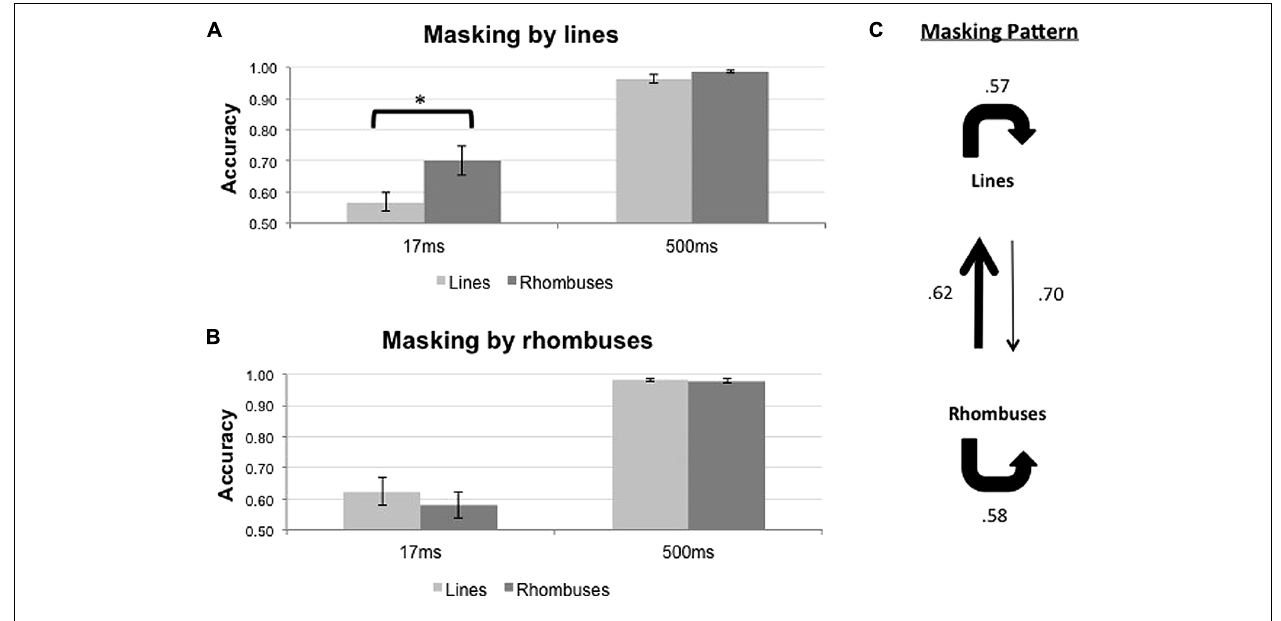
FIGURE 6 | Proportion of correct responses ( n = 10) when lines (light gray bars) or rhombuses (dark gray bars) were masked by (A) lines or (B) rhombuses, across two ISI settings (17 and 500 ms). (C) Masking pattern between lines and rhombuses. Conventions as in Figure 4 .